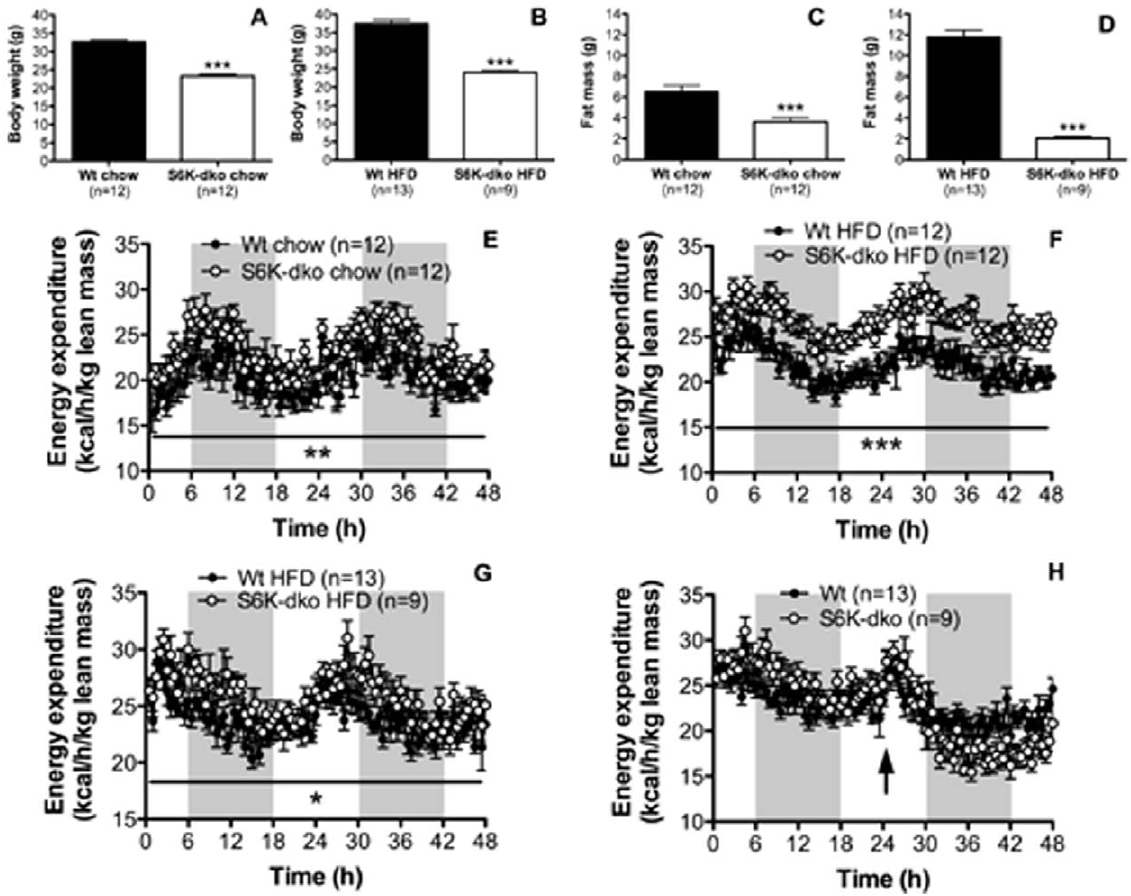
Figure 3. S6K-dko have higher energy expenditure levels. S6K-dko have significantly lower body weight (A) and fat mass (C) than wt controls even when fed a high-fat diet (B, D). Energy expenditure corrected by lean mass levels is higher in S6K-dko when fed standard chow (E), acute high- fat diet (F) or chronic high-fat diet (G) compared to wt controls. Higher energy expenditure in S6K-dko is reduced with 24 h fasting (H). HFD, high-fat diet. Two-tailed t test *** P , 0.001 and two-way ANOVA * P , 0.05, ** P , 0.01, *** P , 0.001. doi:10.1371/journal.pone.0032631.g003 triglycerides (1.72 6 0.1 mg/dl, P , 0.01, n=6) (Fig. 5M) in S6K-dko